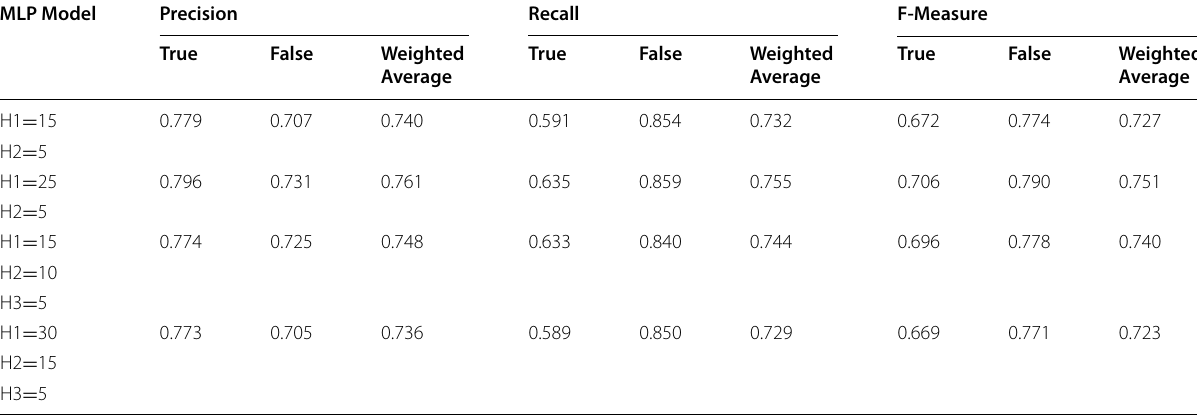
Table 3 Results obtained for Xalan 2.6 dataset MLP Model